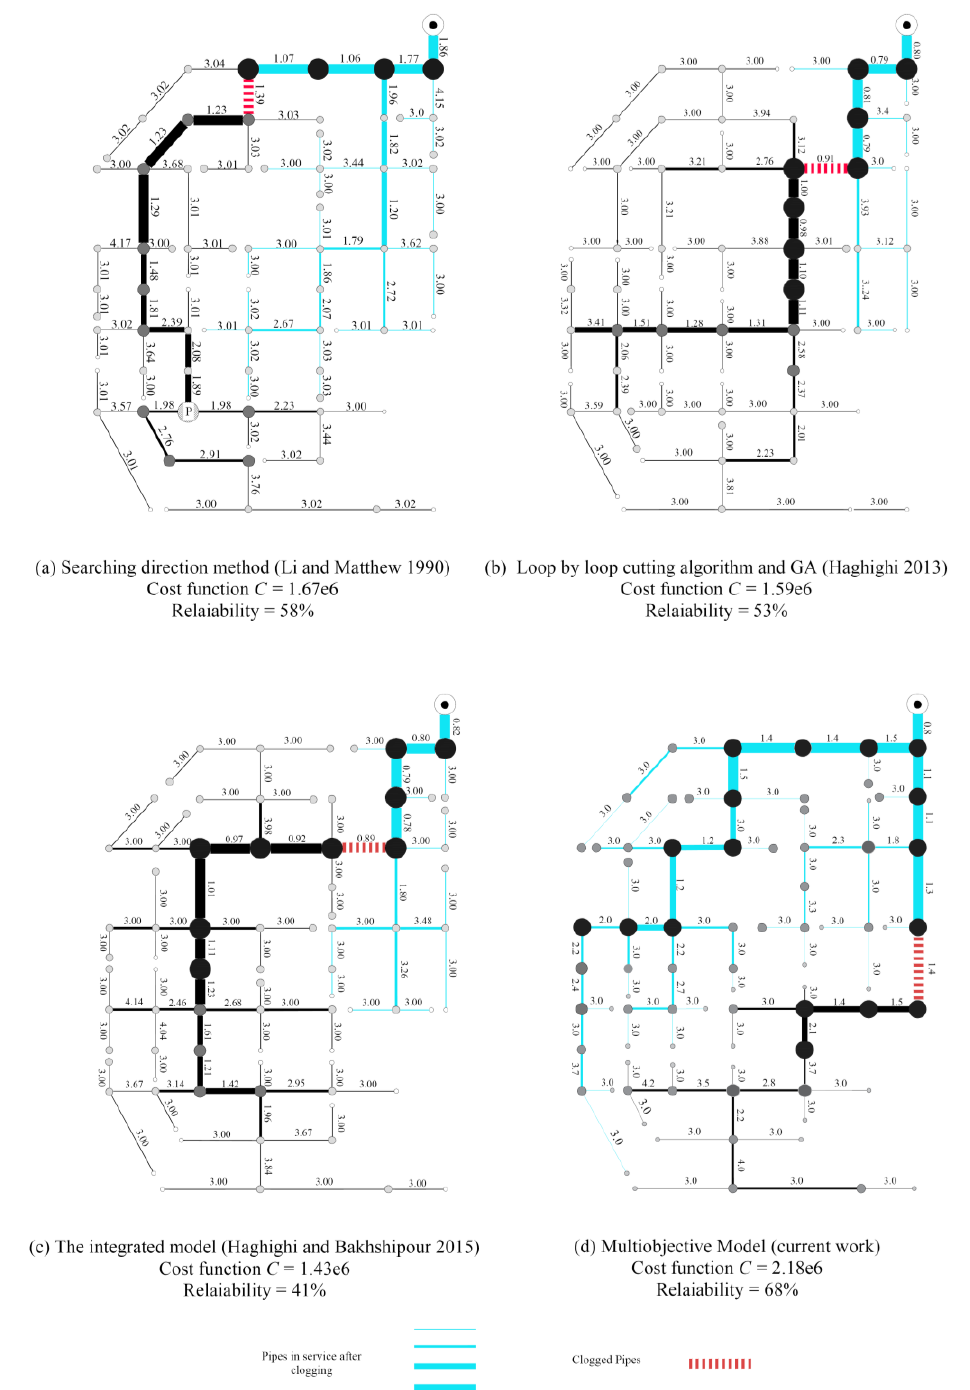
Figure 5. Layout alternatives and the effect of a random pipe